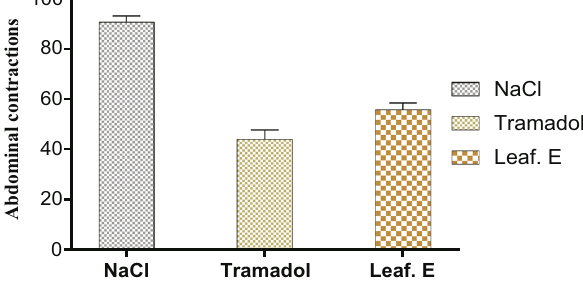
Figure 6: Analgesic activity of the studied extract compared to the tramadol and control group n = 5; *** p <